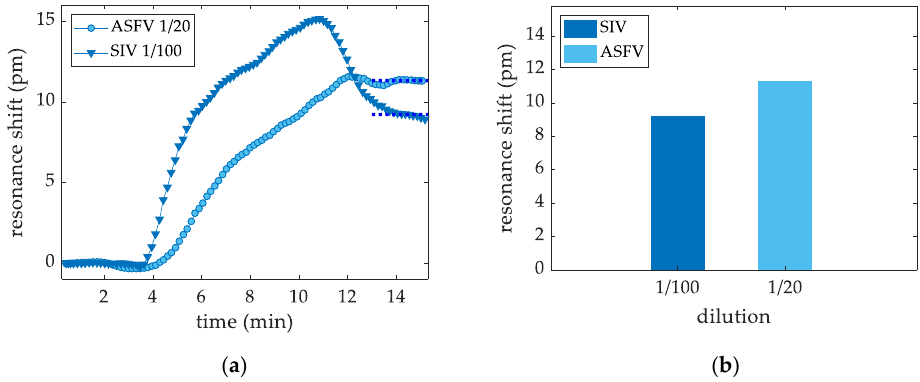
Figure 8. ( a ) Signal shift (measured in pm) obtained for the detection of ASFV and SIV viruses at 1/20 and 1/100 dilutions in PBS-T + BSA 0.5%, respectively. ( b ) The detection levels for each virus tested are summarized in a bar chart.